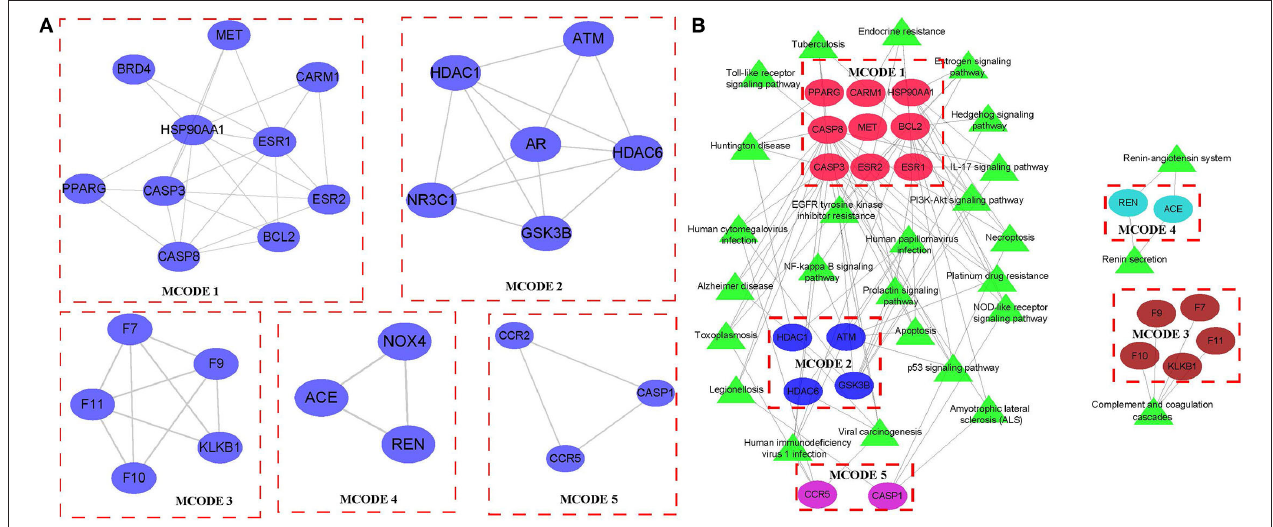
FIGURE 5 | Identification of hub clusters. (A) In total, 5 key clusters were identified in the network based on MCODE. (B) The KEGG enrichment analysis of 5 key clusters.